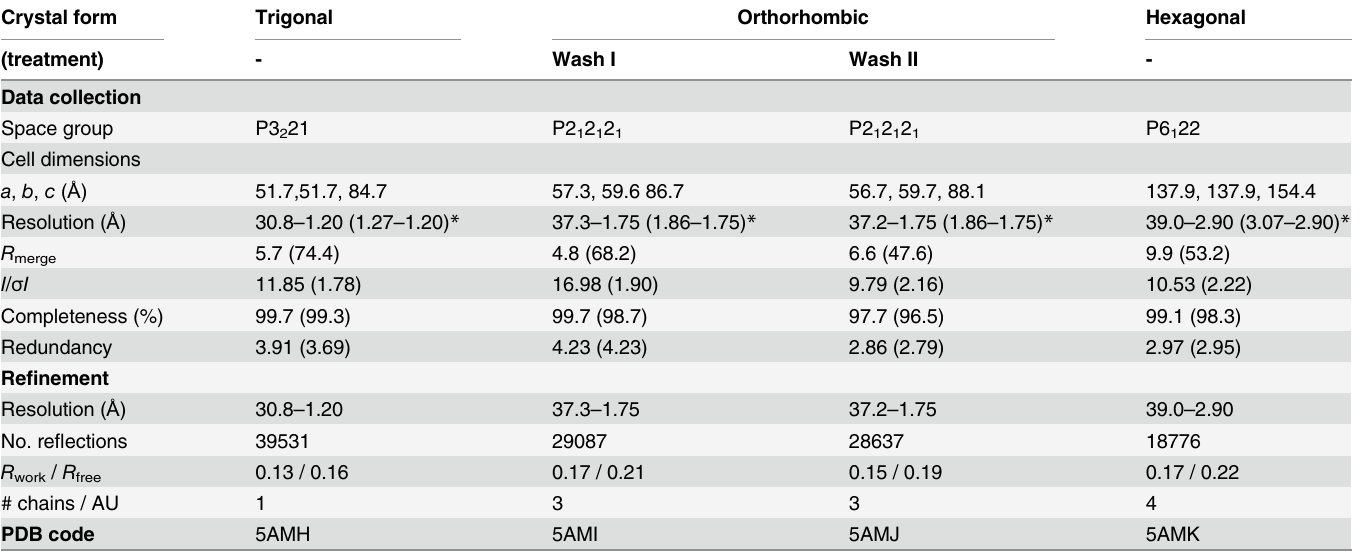
Table 2. Data collection and refinement